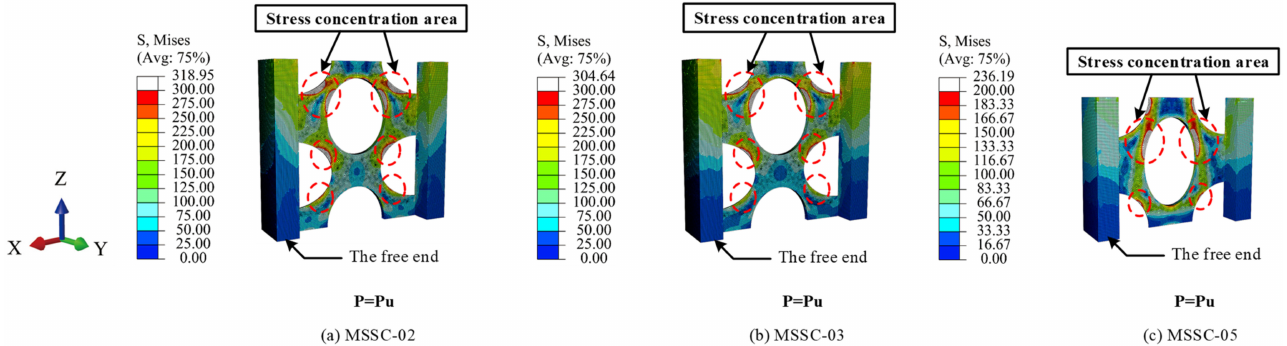
Figure 22. Stress cloud diagram of M-section